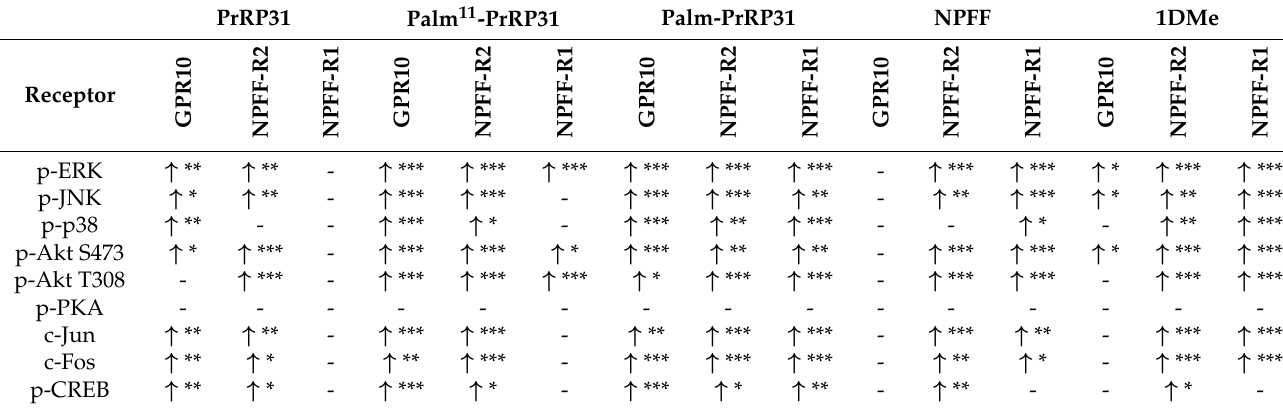
Table 3. Summary table of signaling pathways tested using immunoblot in cells expressing GPR10, NPFF-R2 and NPFF-R1. PrRP31 Palm 11 -PrRP31